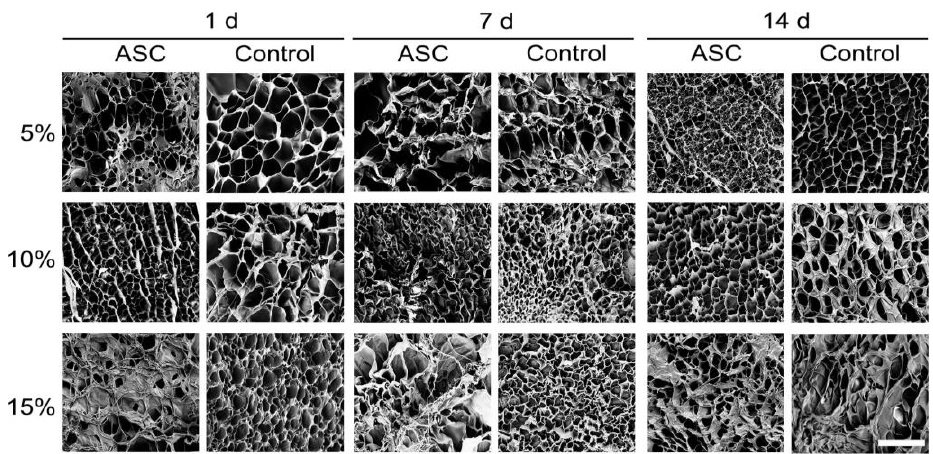
Figure 6. Swelling and mechanical properties of GelMA hydrogels: ( a ) Swelling ratio of cell-loaded (ASC) and cell-free (Control) GelMA hydrogels at 1 d, 7 d, and 14 d, calculated according to Equation (1). Data derived from three independent samples per timepoint. Data are presented as mean with standard deviation. No statistical differences were found according to two-way ANOVA and Tukey. ( b ) Elastic modulus (kPa) and ( c ) stress relaxation (%) of cell-free (Control) GelMA hydrogels after swelling for 24 h. Data derived from a minimum of three independent LLCT measurements per sample, from three independent experiments. Data are presented as mean with standard deviation. Differences in elastic modulus and stress relaxation according to Brown Forsythe and Welch ANOVA and Dunnett’s T3 post-test one-way ANOVA and Tukey’s post-test, respectively. p values are indicated * p < 0.05 and **** p < 0.0001.